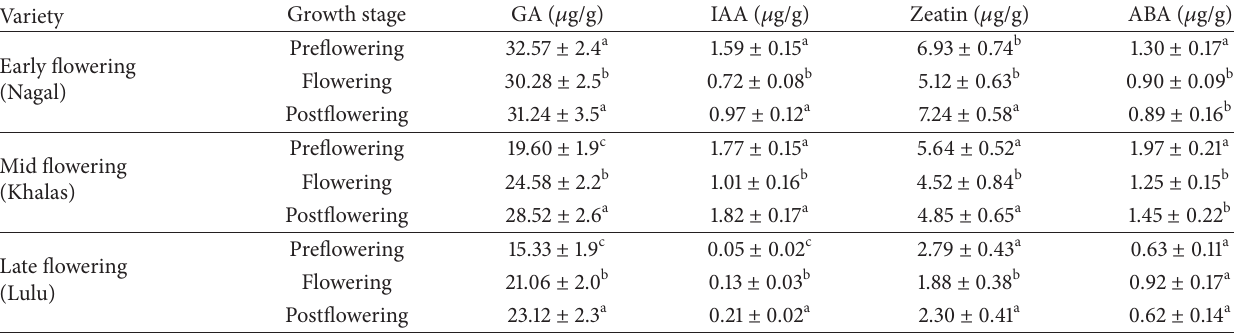
Table 1: Variation in hormone concentrations at different stages of growth in the early, mid, and late varieties of date palm. Variety Growth stage